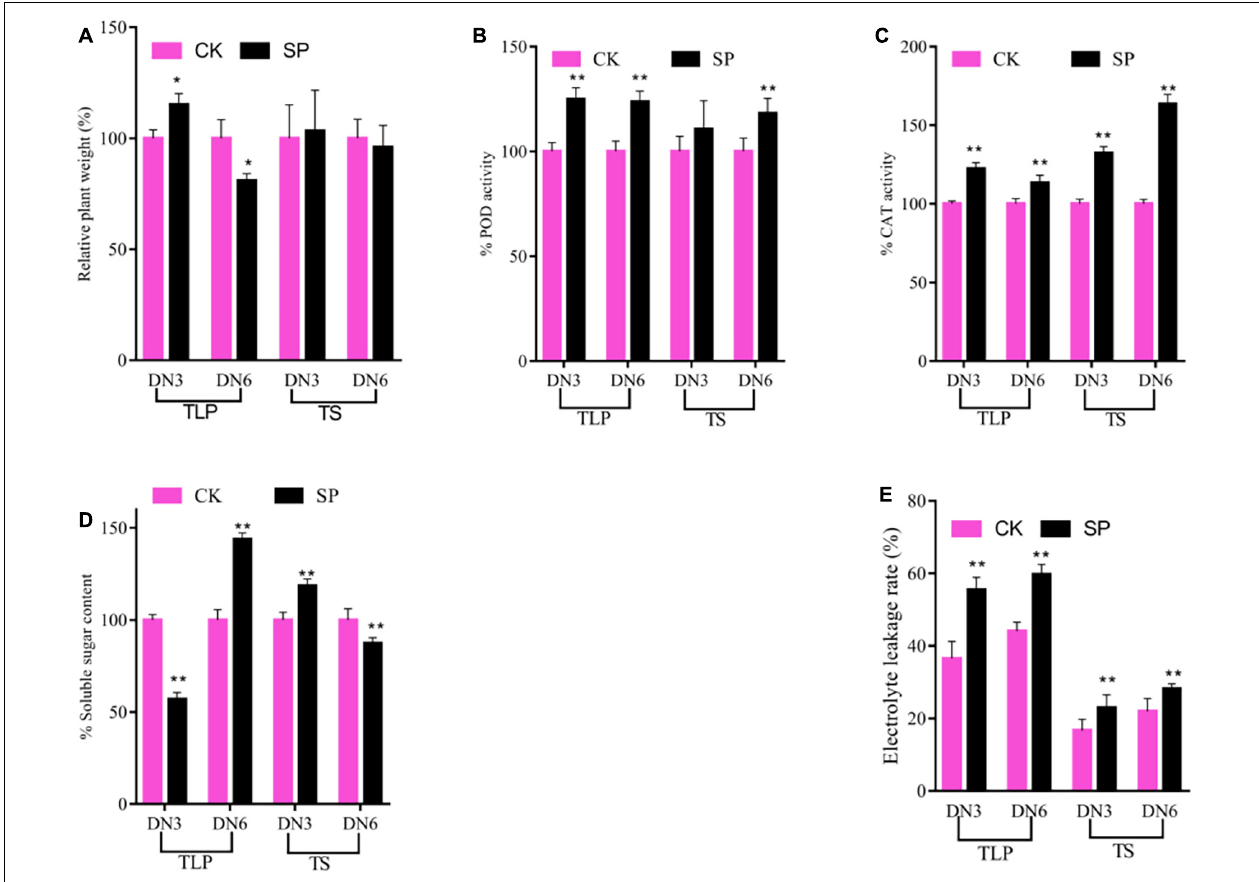
FIGURE 1 | The morphological and physiological changes of rice induced by spaceflight. (A) Percent values of plane weight. (B) Percent values of POD activity. (C) Percent values of CAT activity. (D) Percent values of soluble sugar content. (E) The electrolyte leakage rate change. TLP, three-leaf stage; TS, tillering stage; Pink column represents the control group; black column represents spaceflight group. Data are expressed as mean ± SD, n = 9, * and ** indicate significant difference at p < 0.05 and p < 0.01 by Student’s t -test (GraphPad Prism 7),